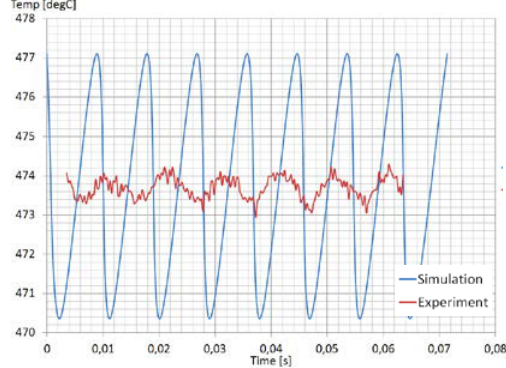
Fig. 13. Comparison of simulated and real average temperature sensor